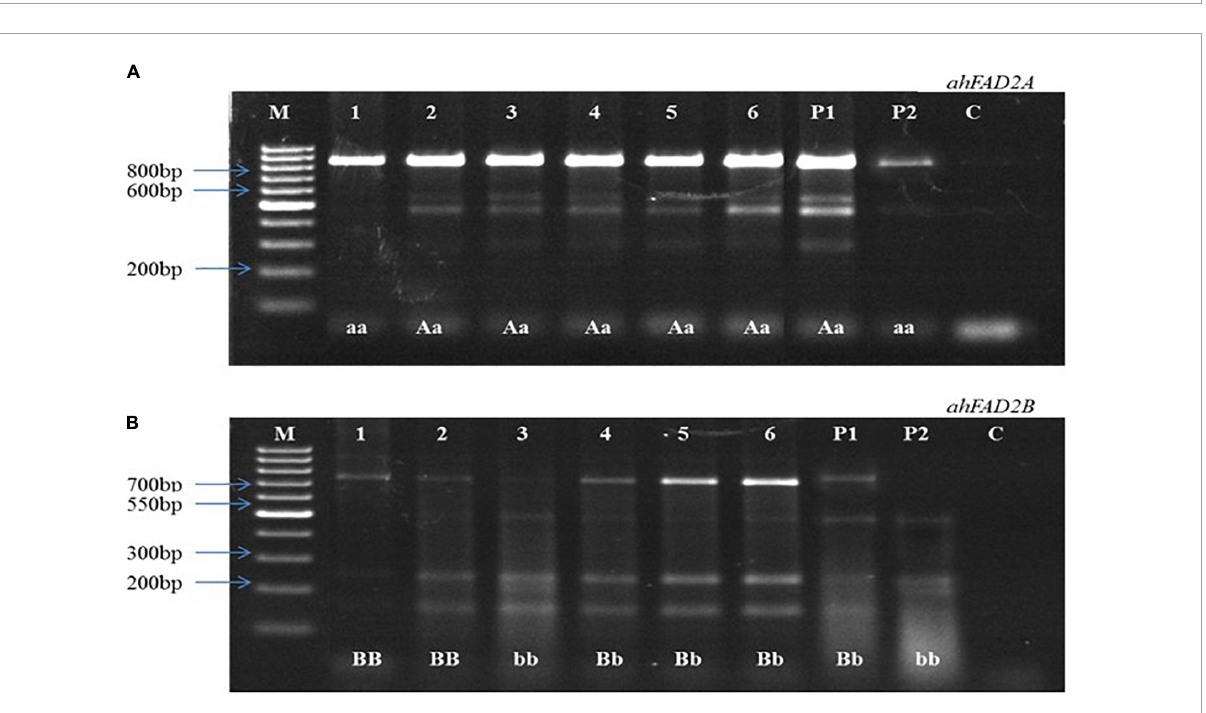
FIGURE3 Representative image of cleaved amplified polymorphic sequences (CAPS). (A) Showing heterozygous and homozygous plants for ahFAD2A mutant allele, (B) Showing heterozygous and homozygous plants for ahFAD2B mutant allele. P1: female parent, P2: male parent, M: 100bp DNA ladder, C: Control, “AA, BB”: homozygous wild alleles, “Aa, Bb”: heterozygous alleles, and “aa, bb”: homozygous mutant